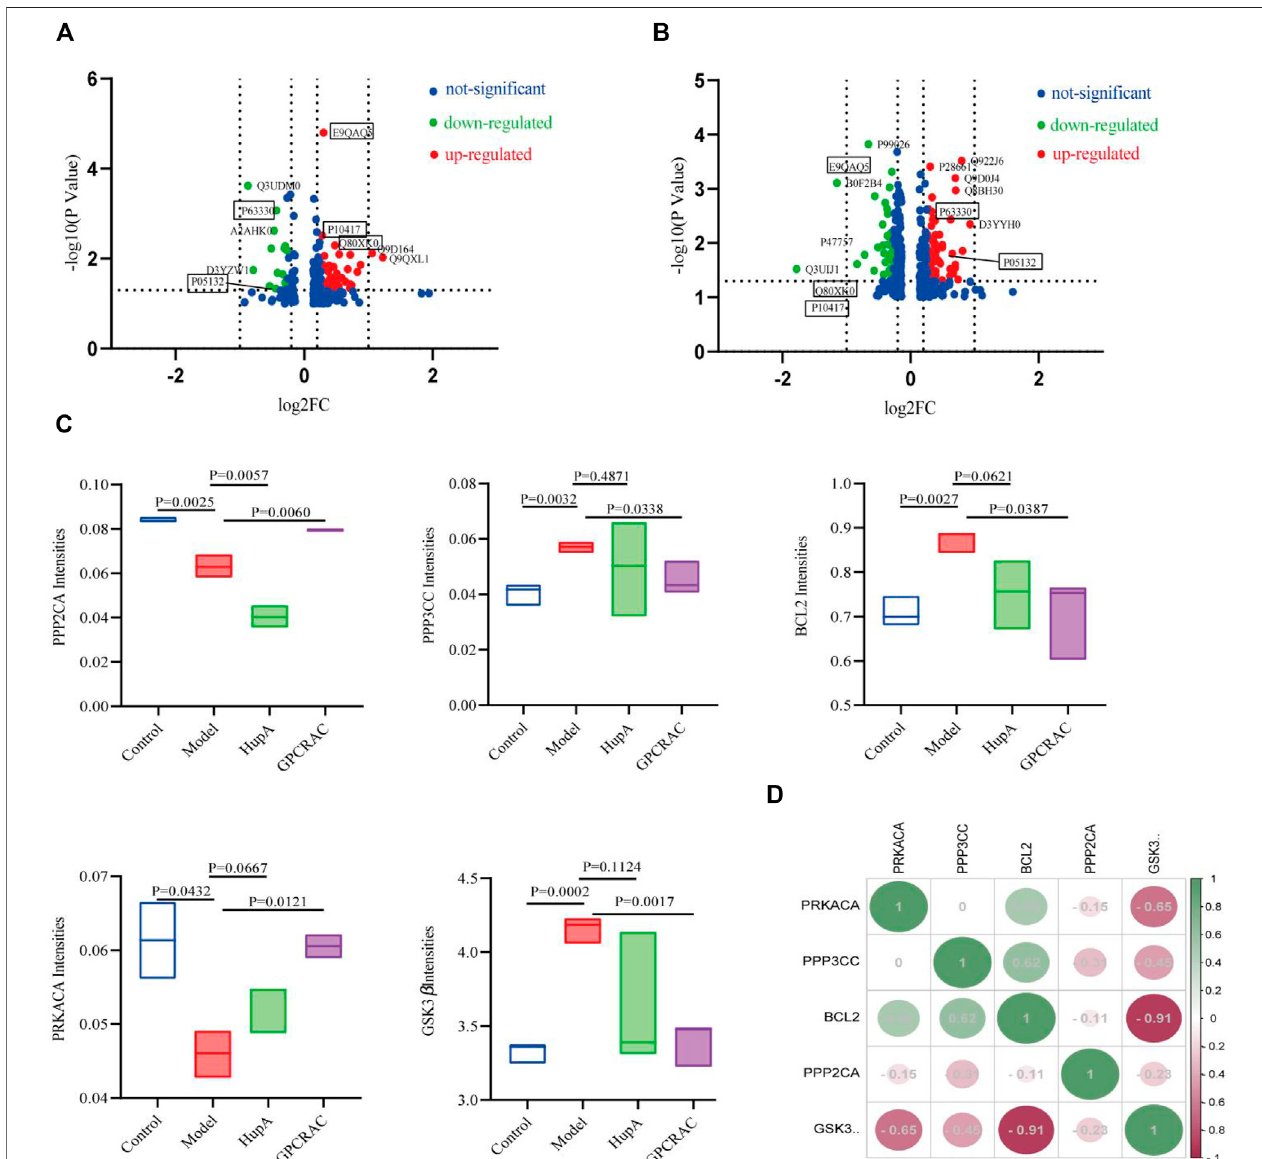
FIGURE 7 | Mapping of hub signi fi cantly regulated proteins. Volcano plots show the distribution of the signi fi cantly altered proteins between control vs. model (A) and model vs. GPCRAC extracts (B) groups; Five proteins (PPP2CA, GSK3 β , PPP3CC, PRKACA, and BCL-2) were identi fi ed as hub differential expressed protein in hippocampusofADmice.Theintensityofprotein isgivenasthenormalized proteinabundance.Signi fi cantchangelevelsof fi veproteinswerepresentedintheboxplots (C) ; Correlation coef fi cients heatmap of hub differentially expressed protein (D) .